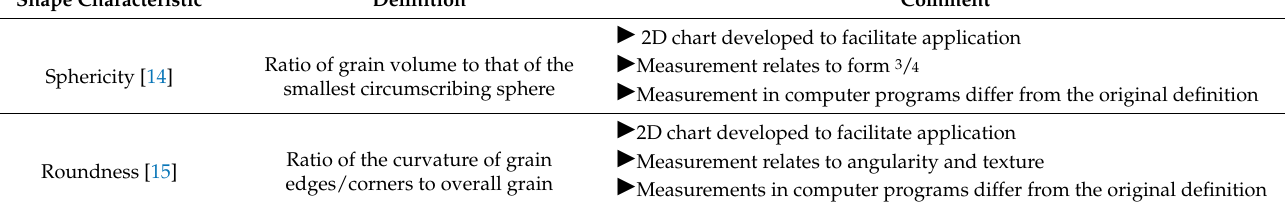
Table 3. Grain shape characterization methods (Adapted from [23]).